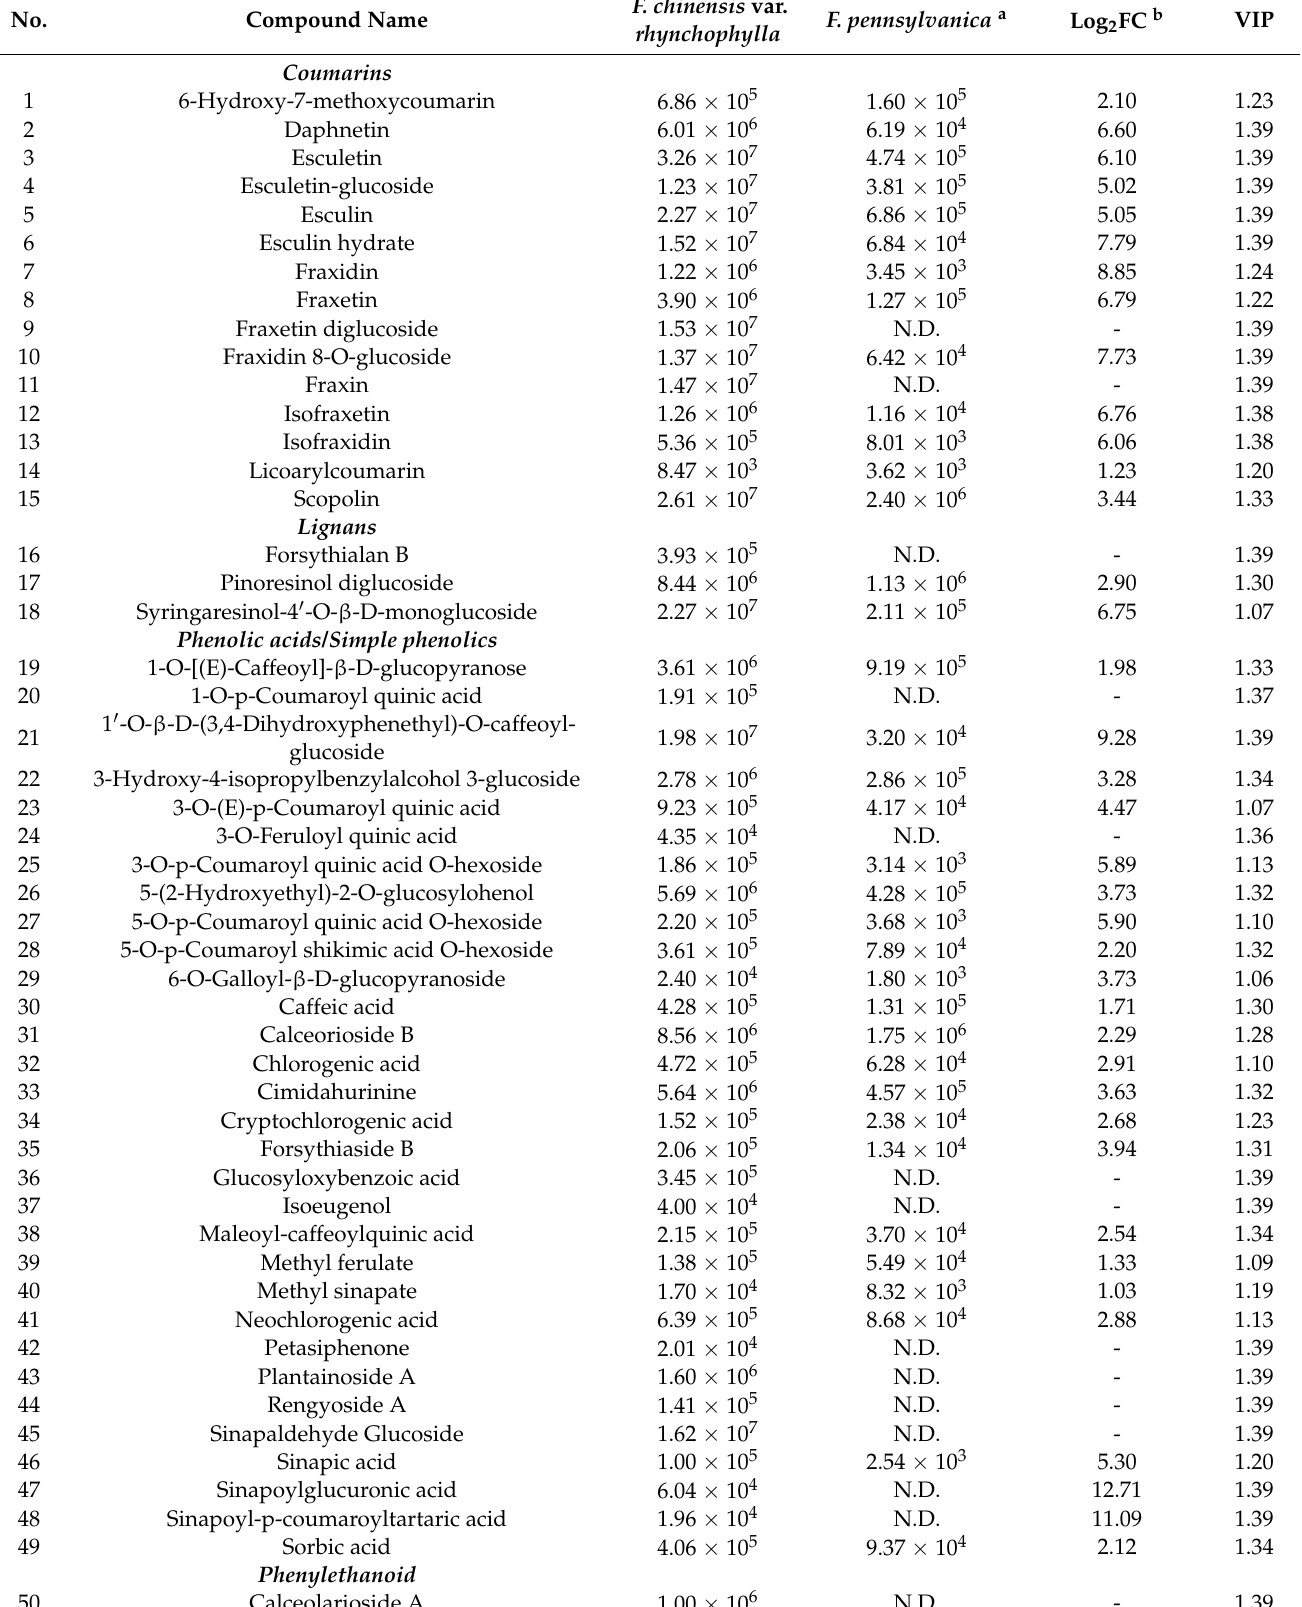
Table 1. The differential metabolites that were detected only or in greater amounts in F. chinensis var. rhynchophylla .